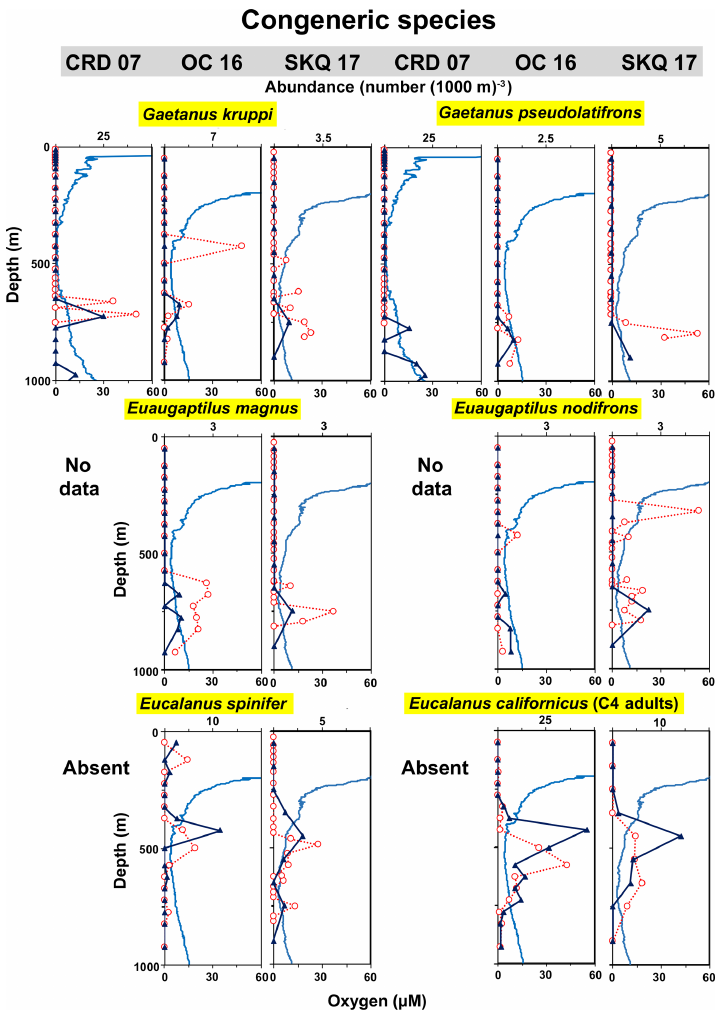
Figure 5. Vertical distributions relative to oxygen: congeneric species from three genera. Each row shows two species (adults) from a particular genus at the same stations (listed at the top and repeated for each half of the figure). Each row is a different genus. See Fig. 3 caption for more